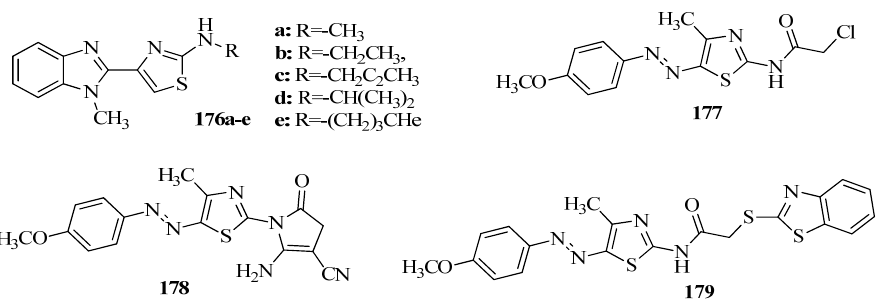
Figure 68. Structures of. 2-alkylamino-4-(1-methylbenzimidazol-2-yl)thiazoles and 4-methyl5- (phenylarylazo)thiazol-2-yl derivatives.